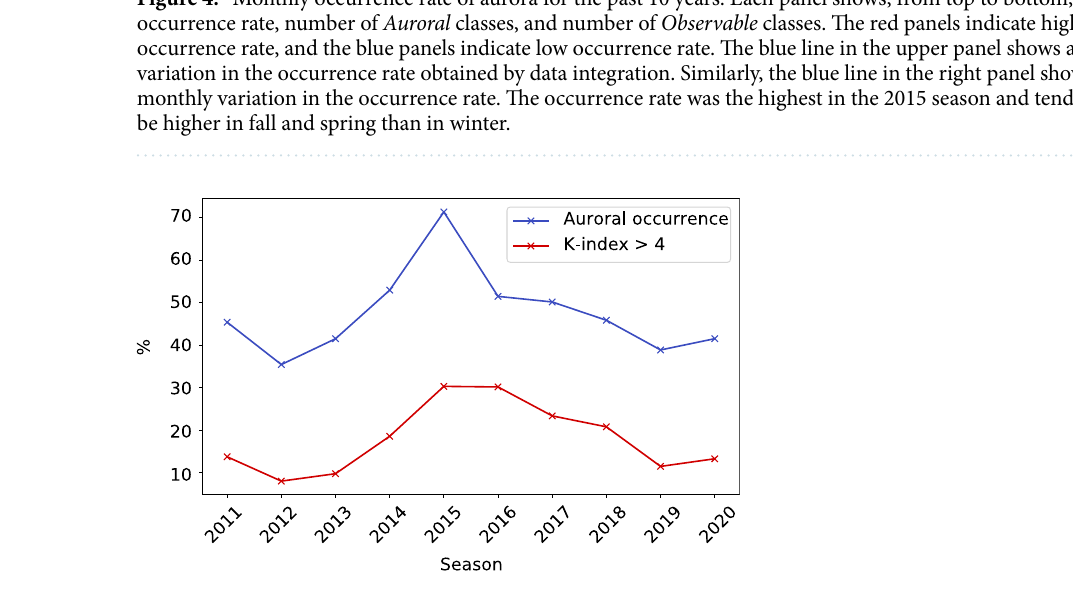
Figure 5. The blue line shows annual variation in the occurrence rate of aurora. The red line shows the percentage of times when the K-index was 4 or higher during clear nights in Tromsø. Years with higher K-index have higher occurrence